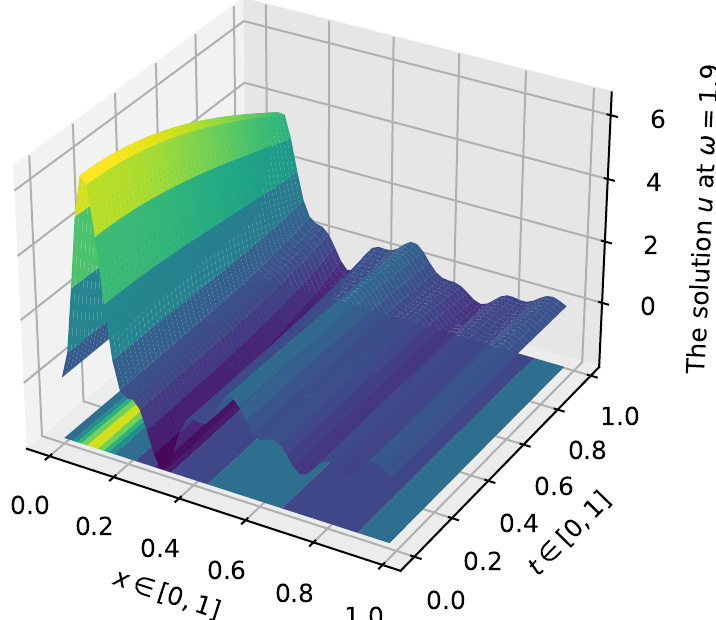
Figure 9. The 3-dimensional graph of solution u on the domain ( x , t ) ∈ [ 0,1 ] × [ 0,1 ] for ω = 1.9.